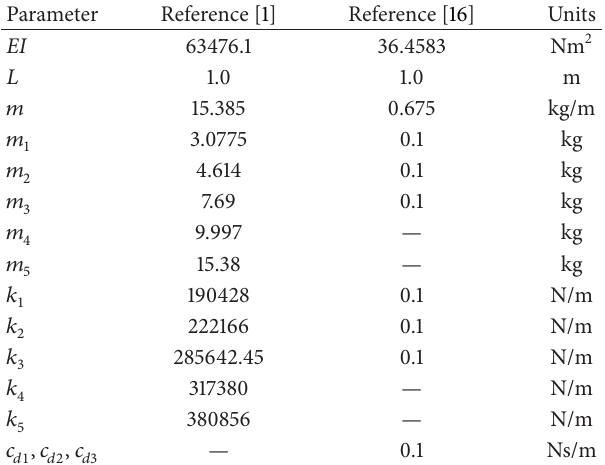
Table 1: Material properties and parameters.